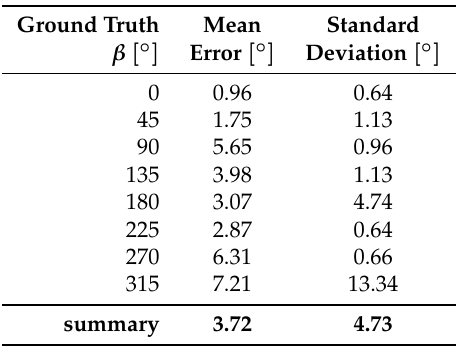
Table 1. Direction detection errors